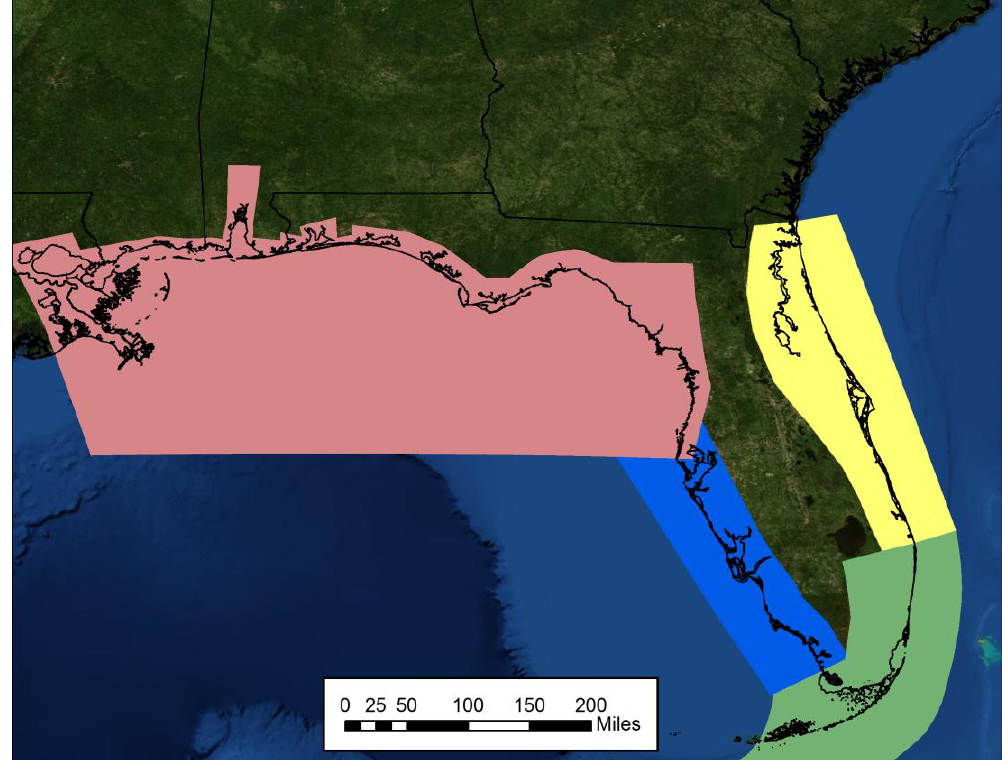
Figure 1. Advanced Coastal Modeling System (ACMS) Florida coast domains: Northern Gulf (NG) of Mexico (pink), Southwest (SW) (blue), Southeast (SE) (green), and East Coast (EC) (yellow).